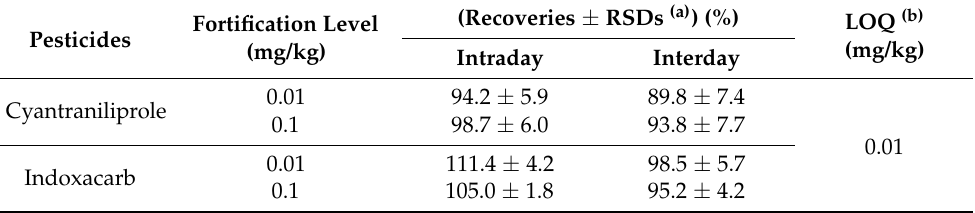
Table 1. Average recoveries (%) and LOQ of cyantraniliprole and indoxacarb in wild garlic. (Recoveries ± RSDs (a) ) (%) LOQ (b) Fortification Level Pesticides (mg/kg) Interday Cyantraniliprole